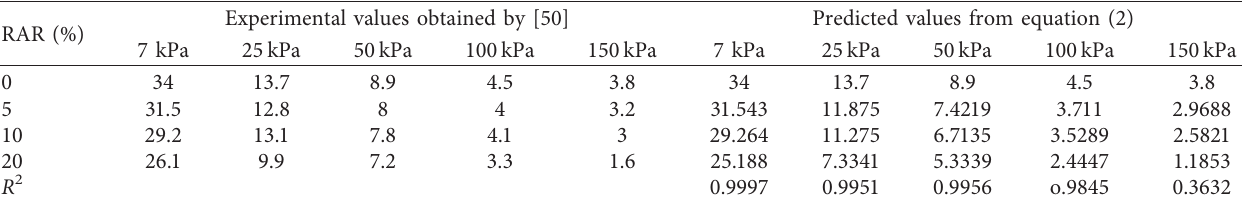
Table 5: Comparison of SPO (%) obtained from equation (3) with that from Herg¨ul [51]. RAR